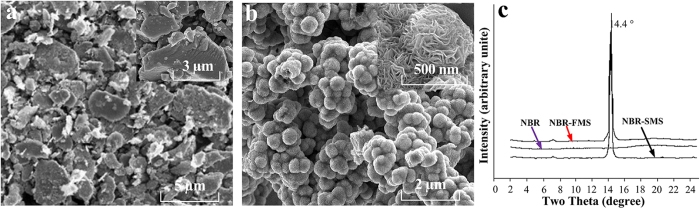
SEM images of (a) flaky MoS2 nanoparticles and (b) spherical MoS2 nanoparticles, (c) x-ray diffraction patterns of the three materials.